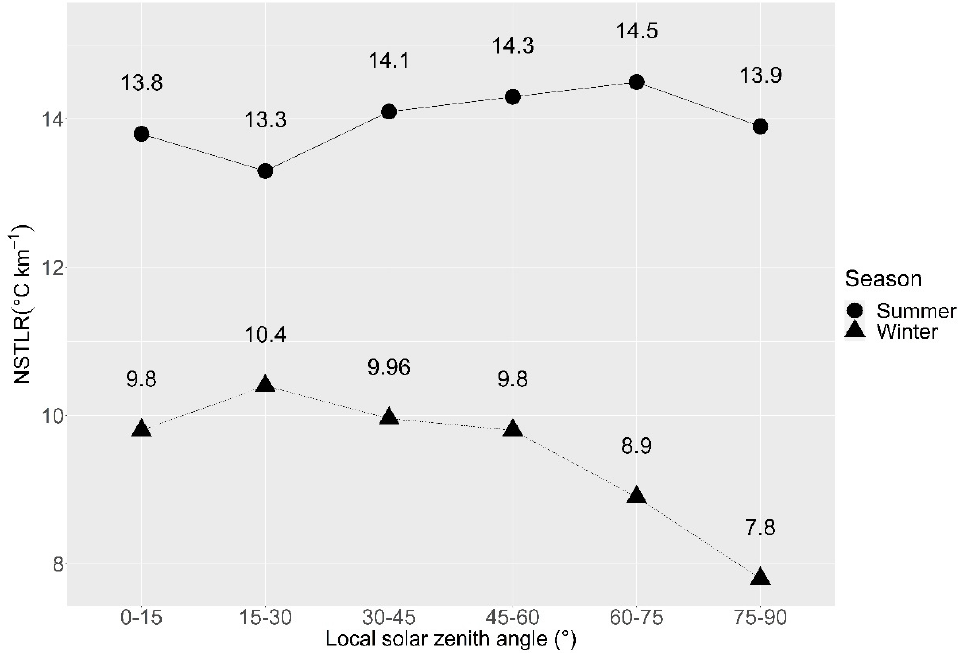
Figure 6. Temperature lapse rate of the two seasons at different Local solar zenith angle.